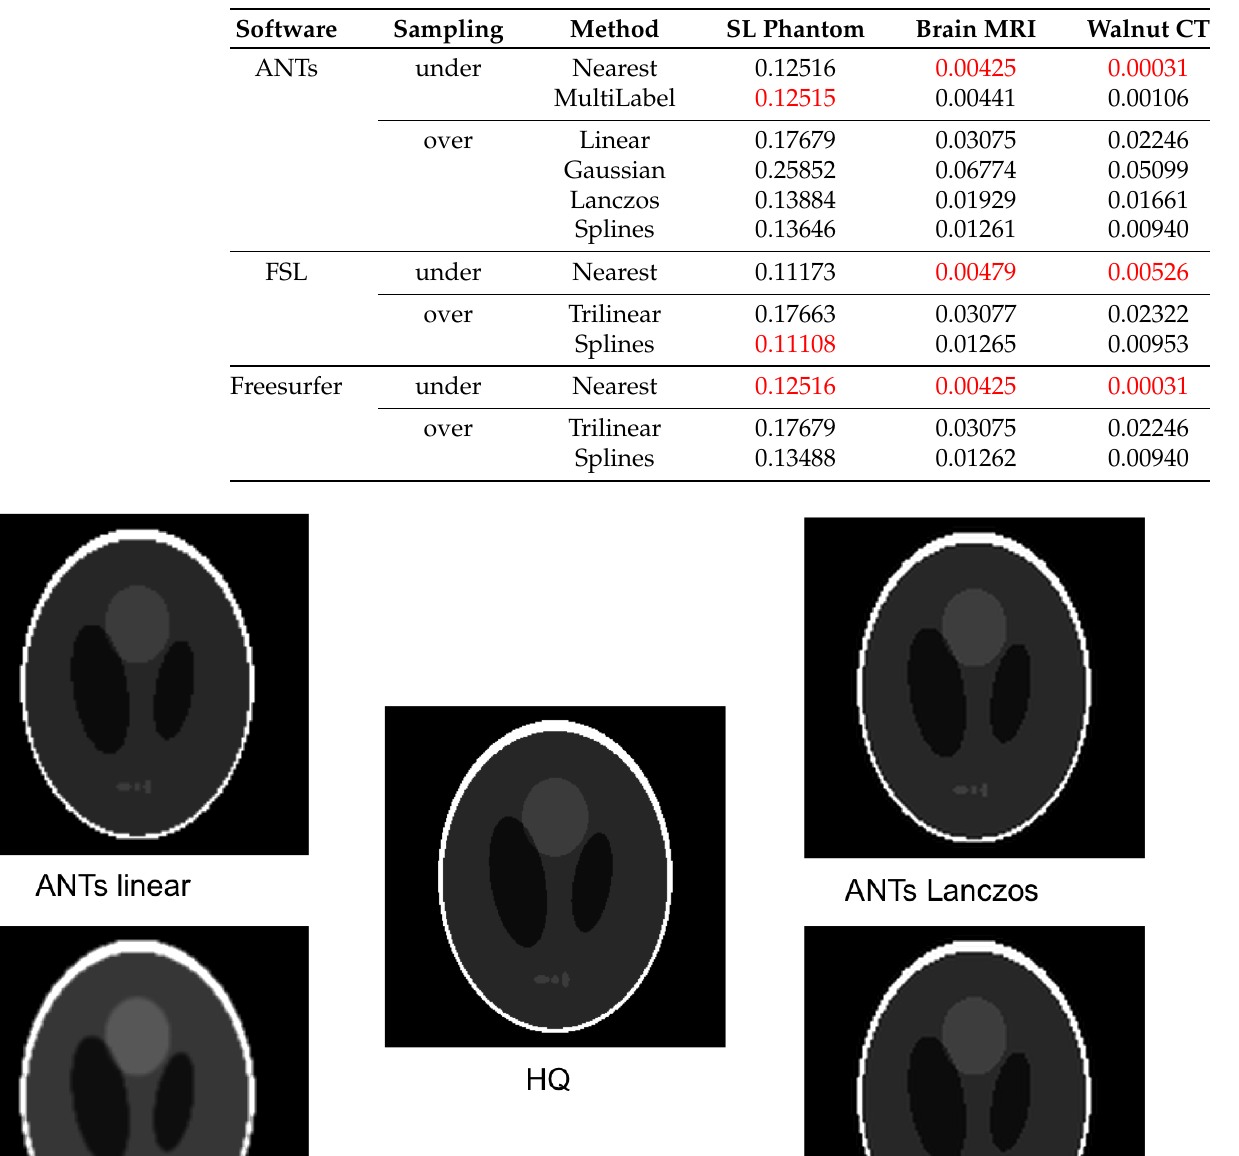
Table 3. Relative errors in ∞ -norm of the mean value per VOI. Minimal error per software per image in red. Empty cells indicate the same as above.